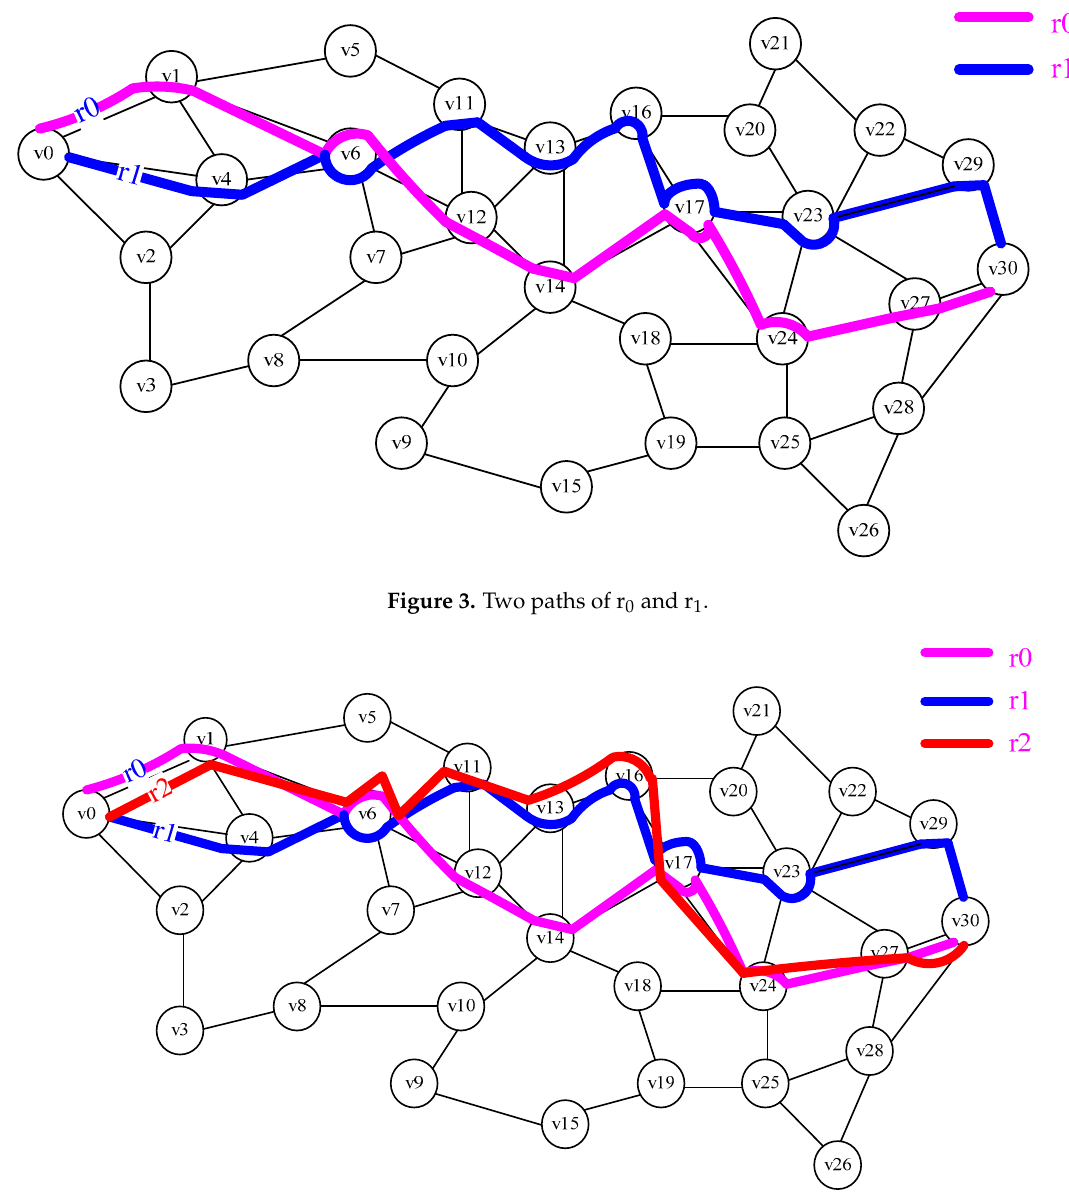
Figure 4. The new paths r 2 generated by r 0 .